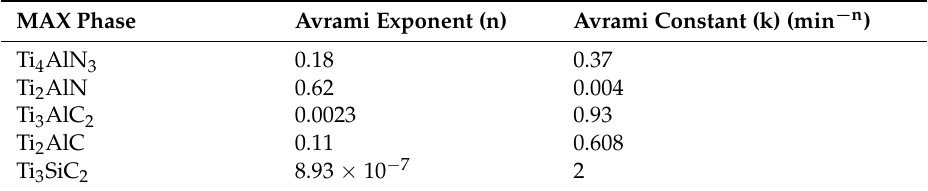
Table 2. Comparison of the Avrami decomposition kinetics in MAX phases. Courtesy of AZom.com [10].